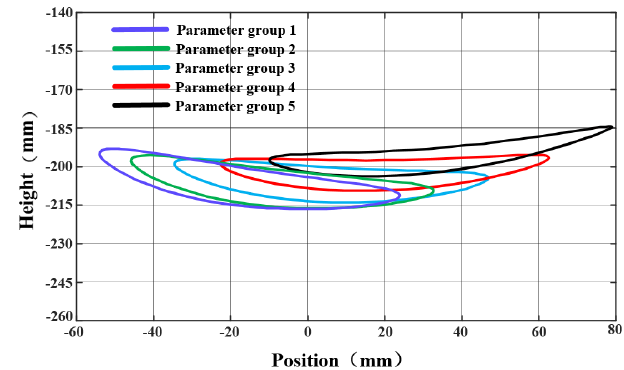
Figure 6. Virtual prototype model of the robot.